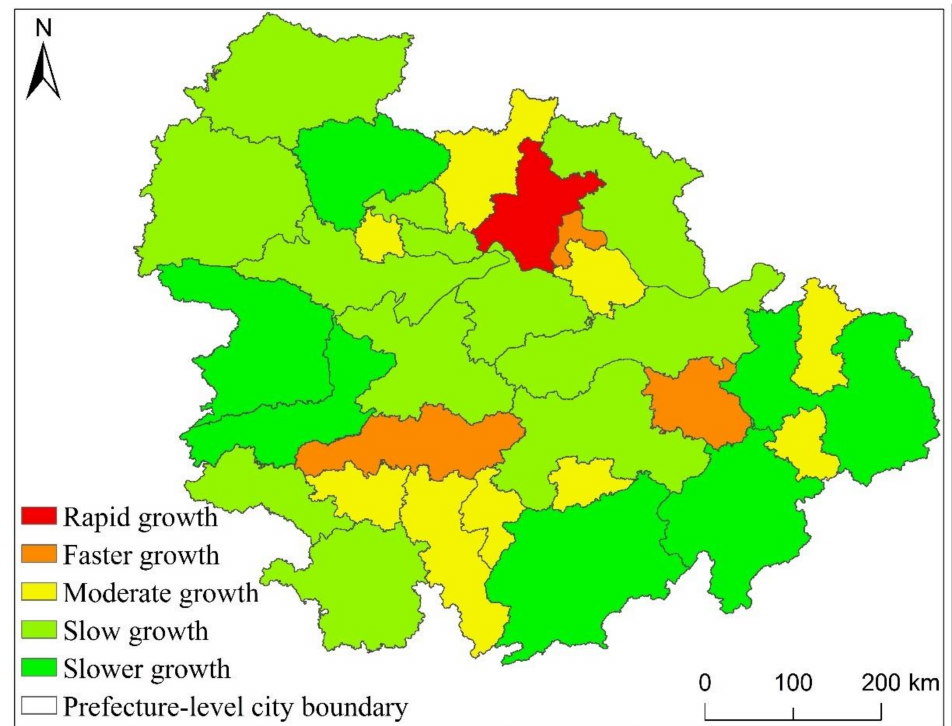
Figure 10. Statistical chart of EPC change trend of UAMRYR from 1992 to